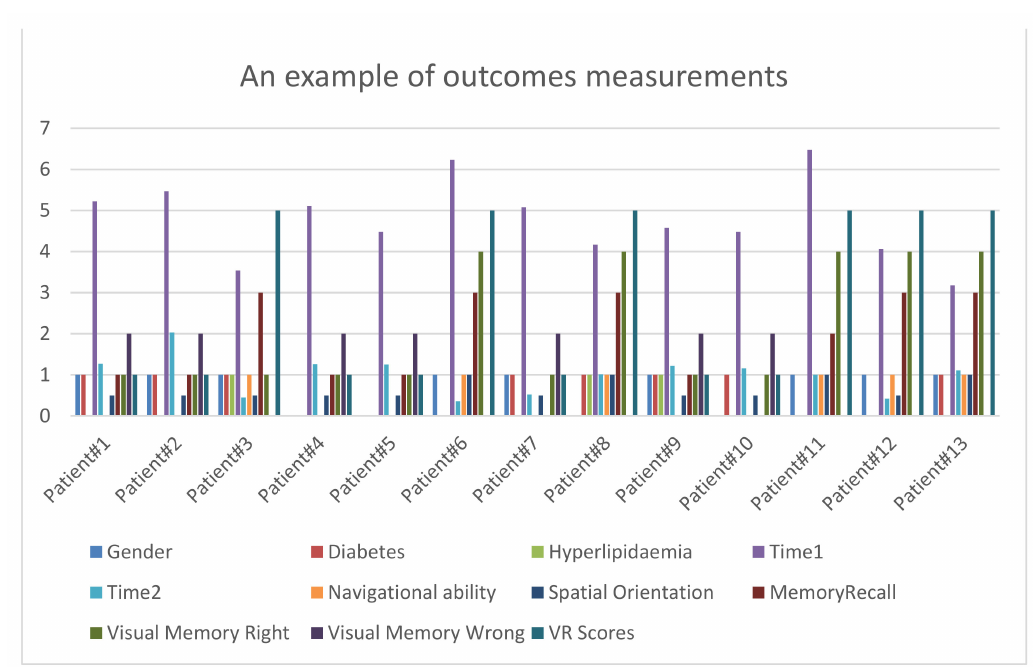
Figure 5. An example of outcomes